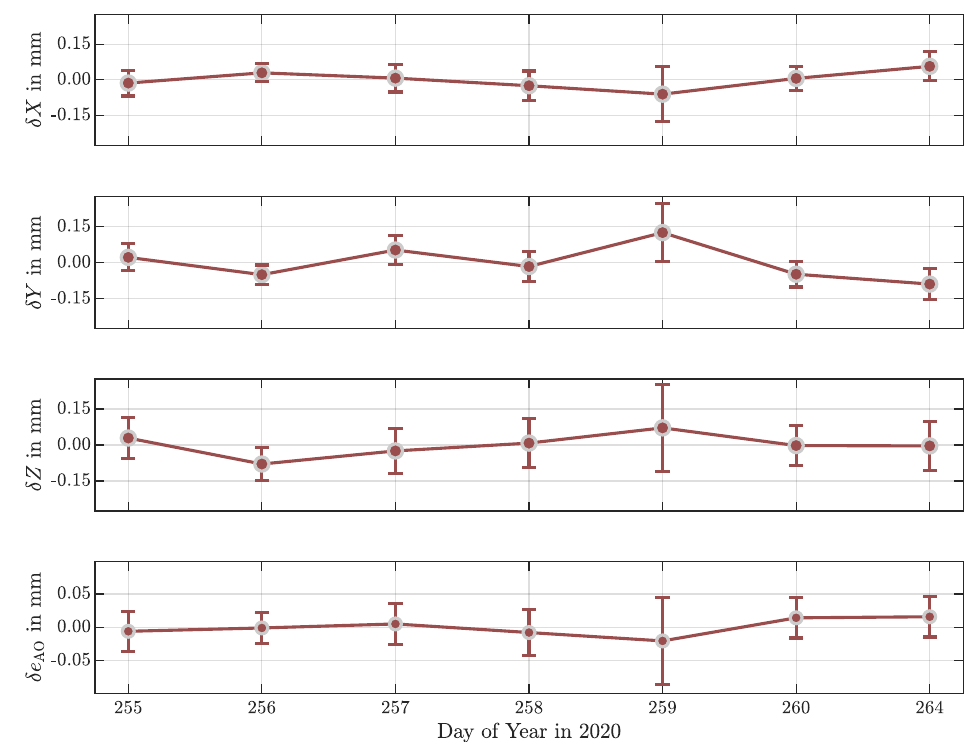
Figure 7. Variations of the coordinate components of the reference point P IRP and the axis offset e AO . Error bars indicate the 3 σ confidence